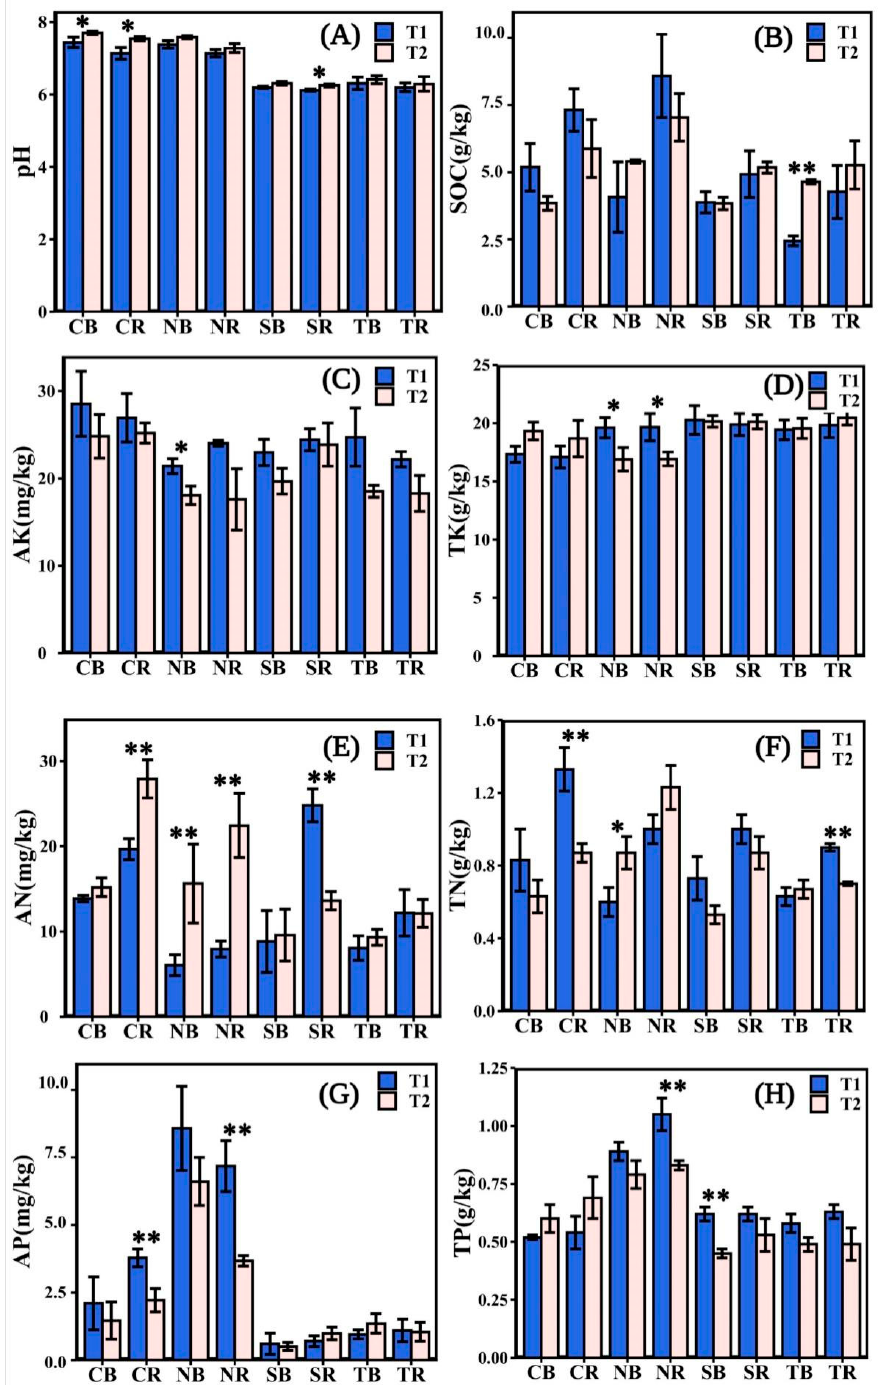
Figure 2. The soil chemical properties measured in different emergence phases (T1 for early phase and T2 for late phase) within the Three Gorges Dam Reservoir, China. The values of pH, soil organic contents (SOC), available potassium (AK), total potassium (TK), alkali hydrolyzed nitrogen (AN), total nitrogen (TN), available phosphorus (AP), total phosphorus (TP) available in the rhizosphere and bulk soil measured for selected plants in ( A – H ). Note: bars indicate significant differences at p < 0.01 (**) or p < 0.05 (*) according to the paired t -tests. Abbreviations in the figure define as bulk soil (B), rhizosphere soil (R), Cynodon dactylon (C), Hemarthria altissima (N), Salix matsudana (S), Taxodium distichum